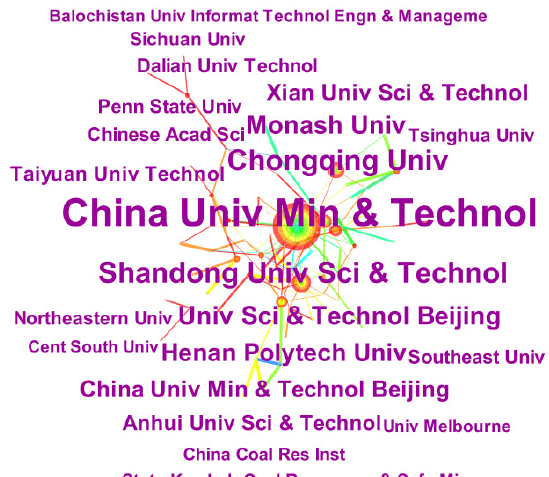
Figure 7. Institution cooperation network.